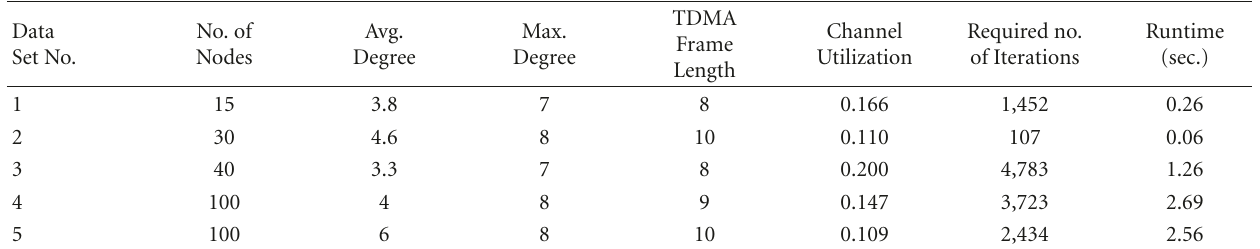
Table 1: Experimental Results with Benchmark Data Sets.